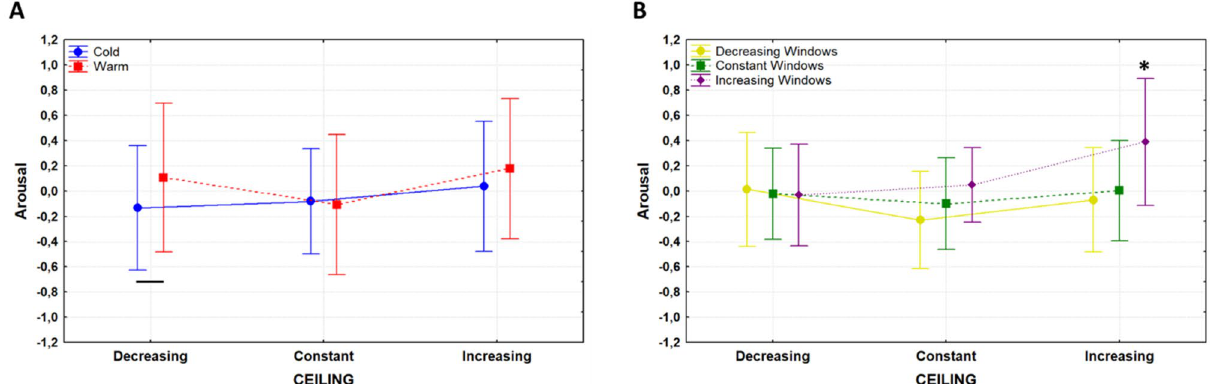
Figure 5. ( A ) distribution of the arousal scores for the two-way interaction Color × Ceiling. Blue and red lines represent cold and warm architectural designs, respectively. ( B ) Distribution of the arousal scores for the two- way interaction Windows x Ceiling, same color code as Fig. 3.